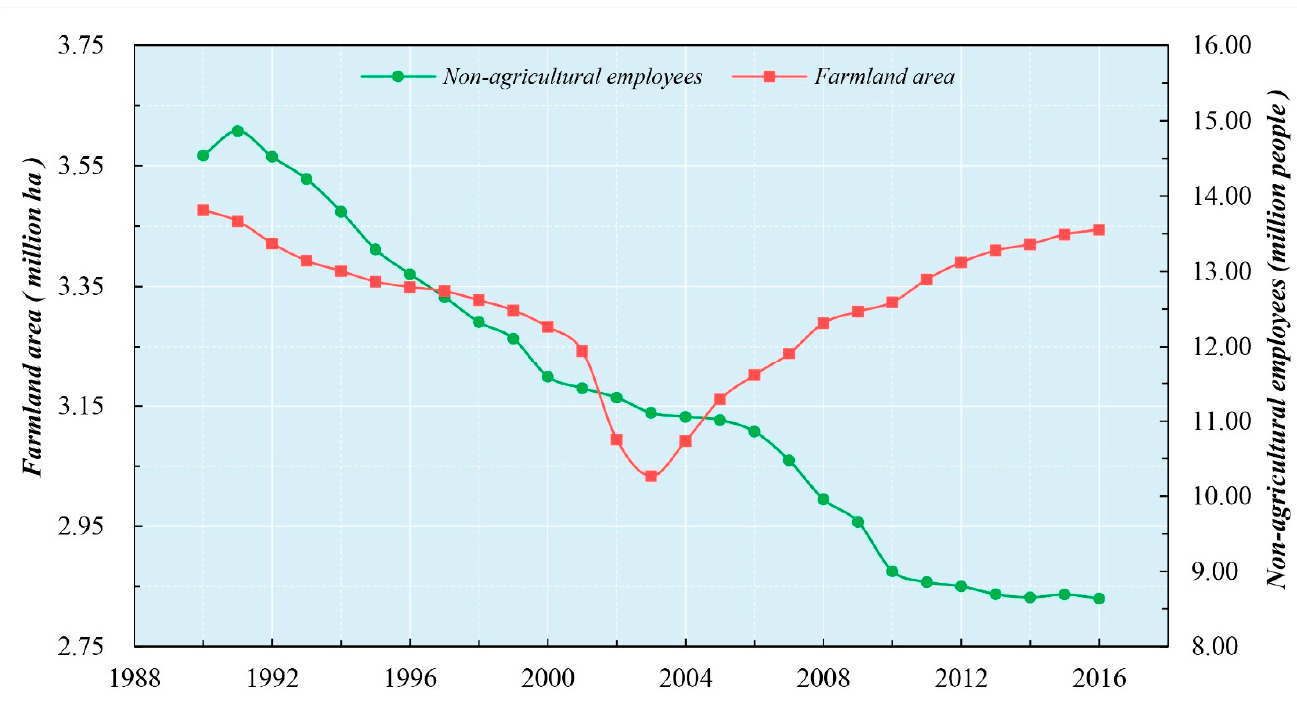
Figure 4. The driving mechanism of the area proportion of paddy fields within Hubei province between 1990 and 2016. Data source: the Rural Statistical Yearbook of Hubei Province 1991–2017.